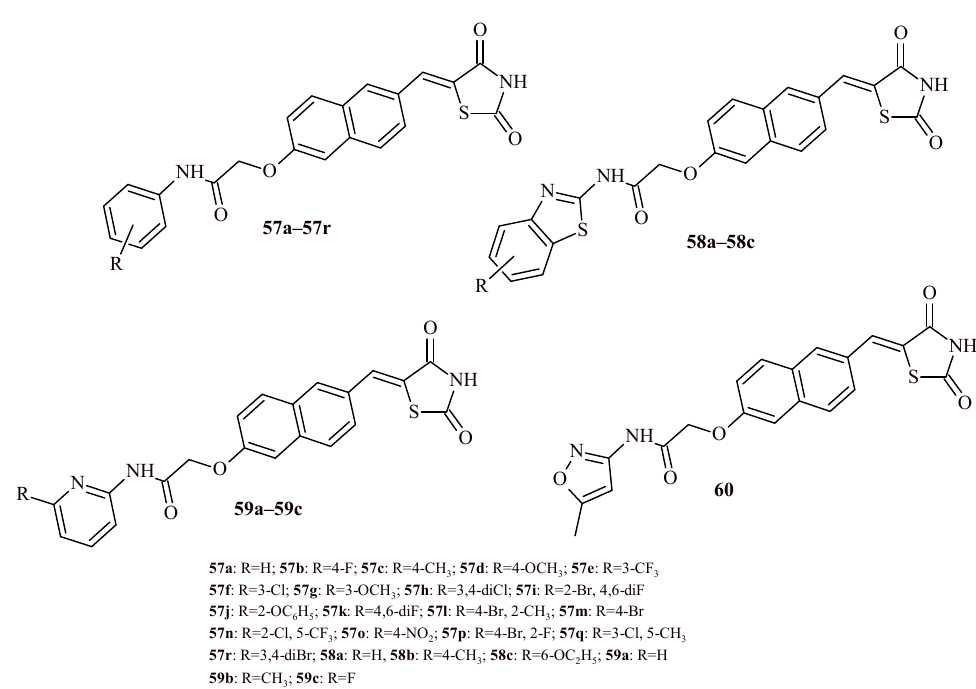
Figure Figure 24. The structures of thiazolidine-2,4-dione derivatives with PPAR γ and HDAC target sim- ultaneously.